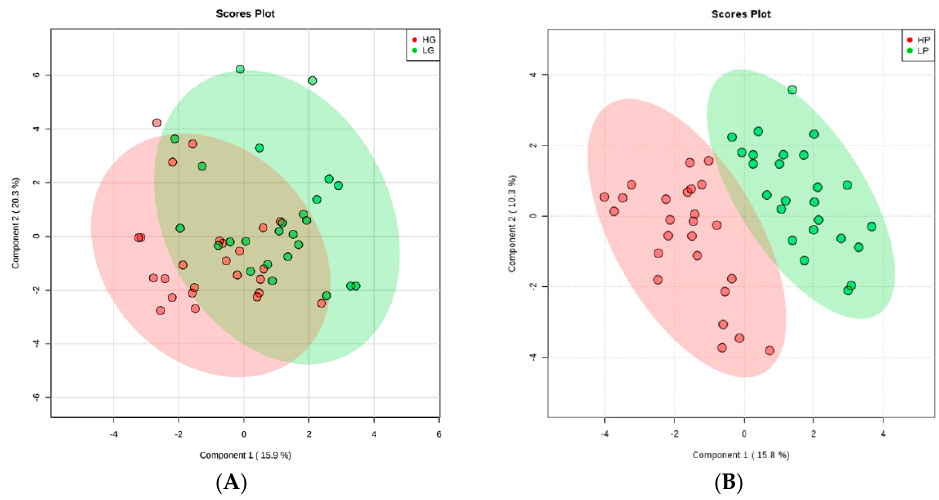
Figure 1. Partial least squares discriminant analysis (PLS-DA) obtained from employing the metabolic concentration of all metabolites detected in the muscle tissue of animals according to: ( A ) Growth: high growth (HG) and low growth (LG) animals are represented by the red and green colors, respectively; and ( B ) Precocity: high precocity (HP) and low precocity (LP) animals represented by the red and green colors, respectively. The validation analysis for growth resulted in the R2 = 0.427, Q2 = 0.105, and Accuracy = 0.64 (Figure S1: Validation statistics for PLS-DA on animals selected for growth); for precocity, R2 = 0.795, Q2 = 0.523, and Accuracy = 0.92 (Figure S2: Validation statistics for PLS-DA on animals selected for precocity). Table 1. Asymptotic general independence test (Permutation) and two-sample Kolmogorov–Smirnov test (KS) applied for muscle metabolites in animals with genetic potential for